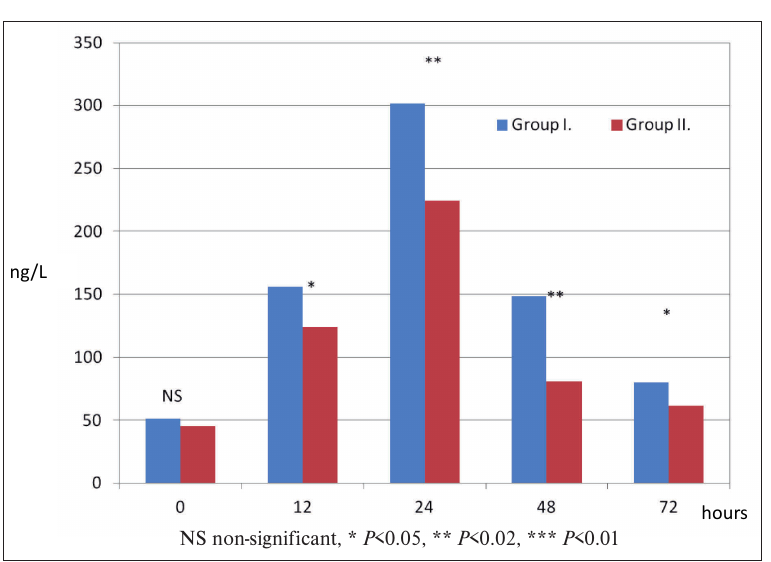
Fig. 2. Serum leptin before and after surgery in Group I and Group II (mean values).